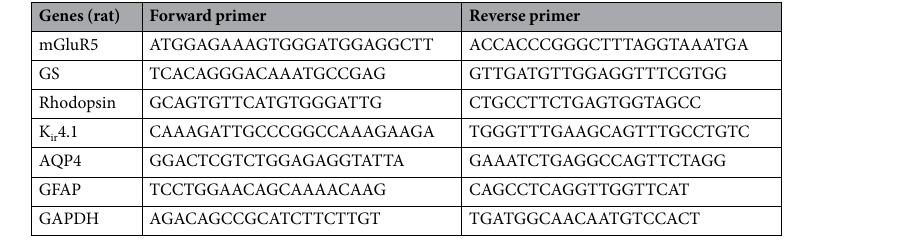
Table 2. Design of RT-PCR